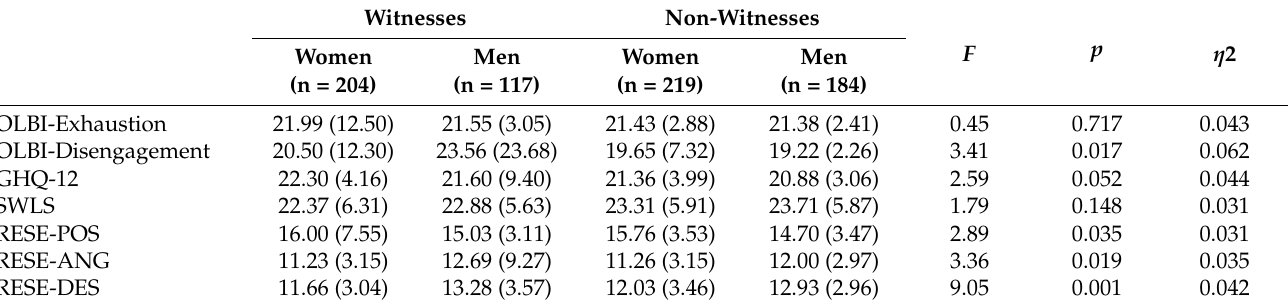
Table 2. Perceived mental health, life satisfaction, burnout, and self-efficacy; comparison between